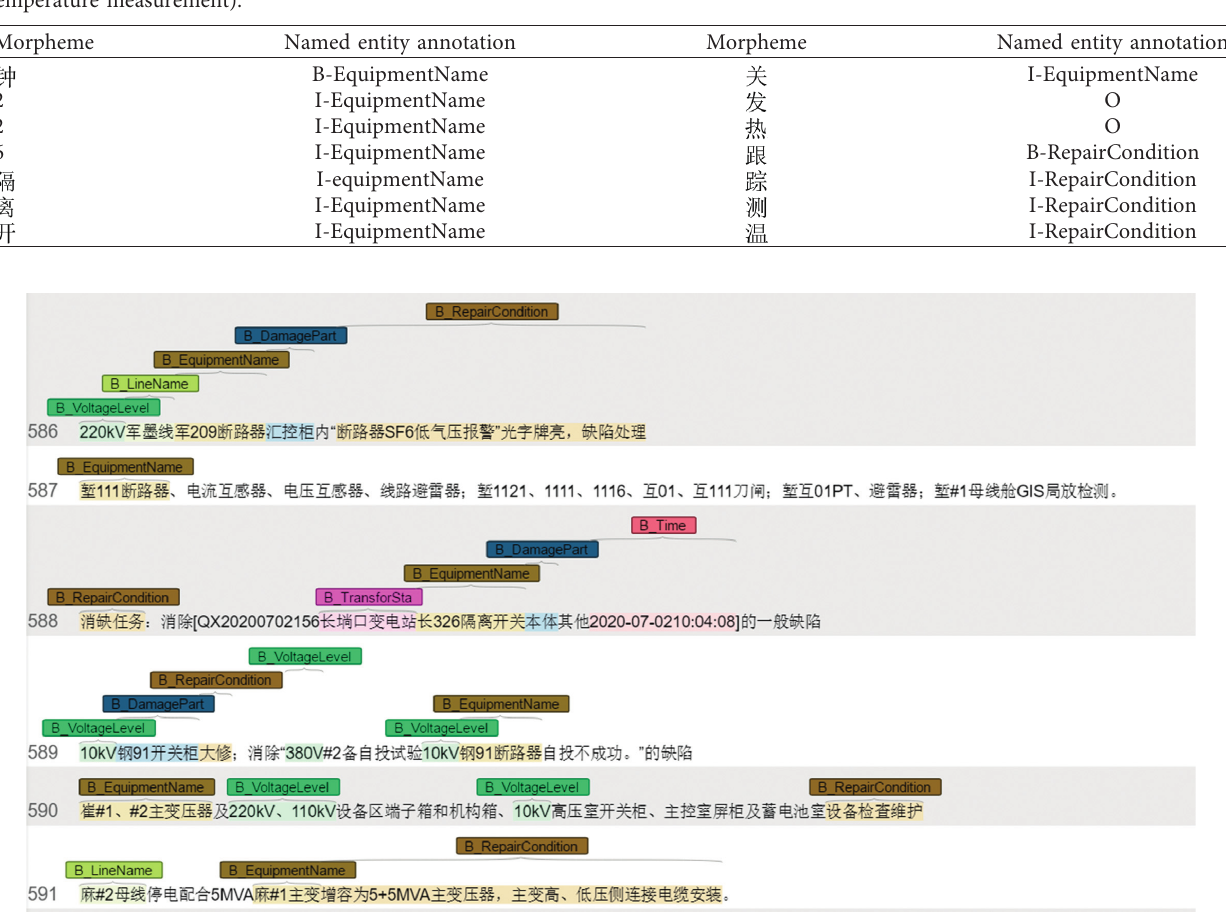
Figure 2: Example of EPE-MR dataset.